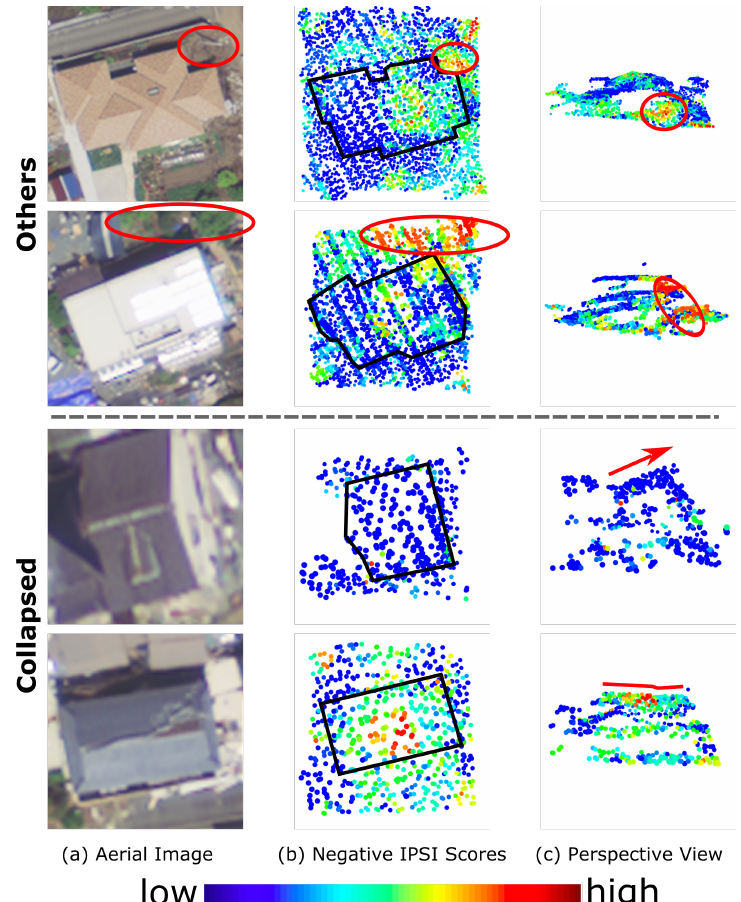
Figure 11. Examples of misclassifications using building patches. Buildings in the first two rows belong to the “others” class, but were misclassified as “collapsed”, whereas buildings in the last two rows belong to “collapsed”, but were misclassified as “others”. ( a ) shows aerial images [12]; ( b ) shows negative IPSI scores (patch); black lines depict the boundaries of building roofs; and ( c ) shows the perspective views, from which the causes misclassification can be clearly